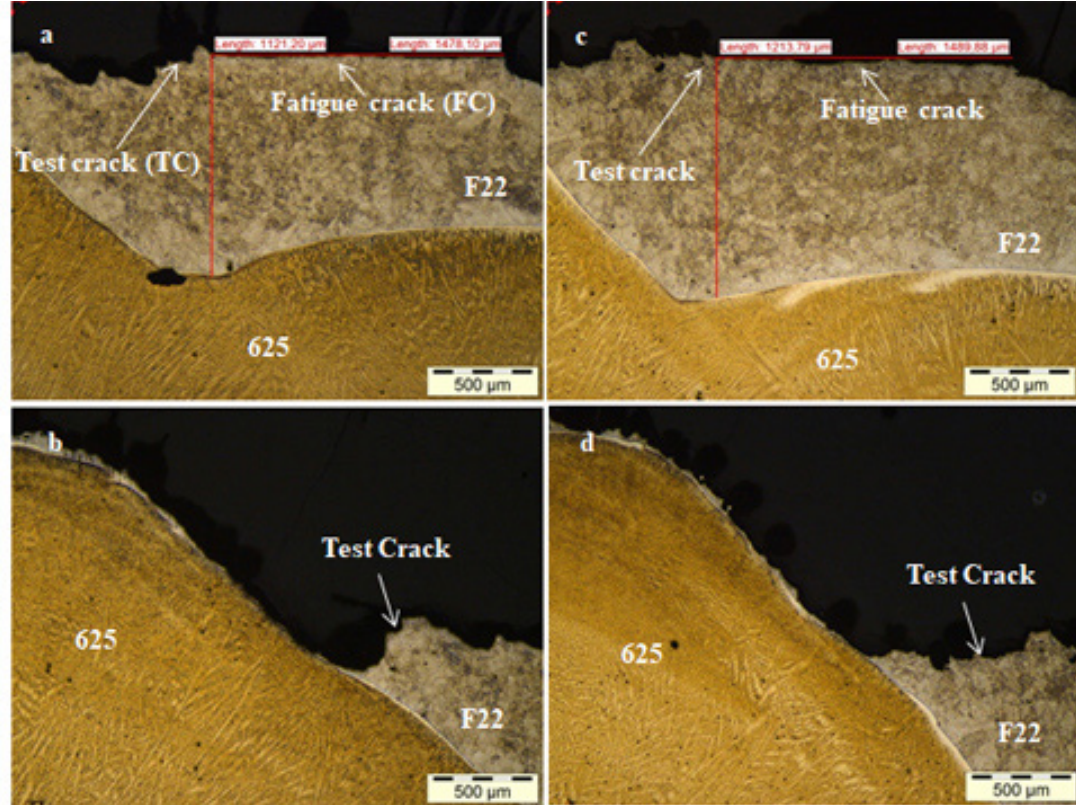
Figure 21. Fatigue cracks optical microscopy and testing of welded joint CTOD specimens, steel ASTM A182 F22 - Inconel 625 - steel ASTM A36(increase of 50x). (a) and (b) without hydrogenation. (c) e (d) with hydrogenation.